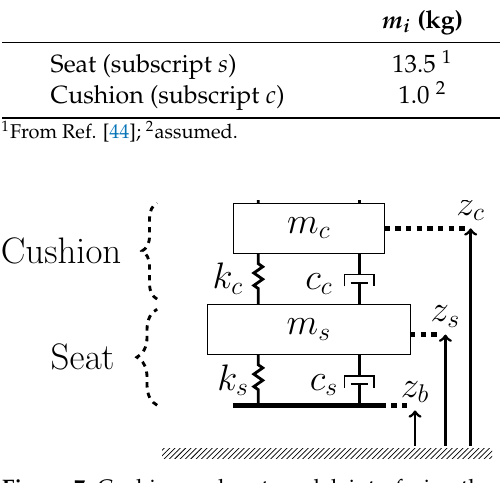
Figure 7. Cushion and seat model, interfacing the pilot’s body to the cabin floor (adapted from [44]; data in Table